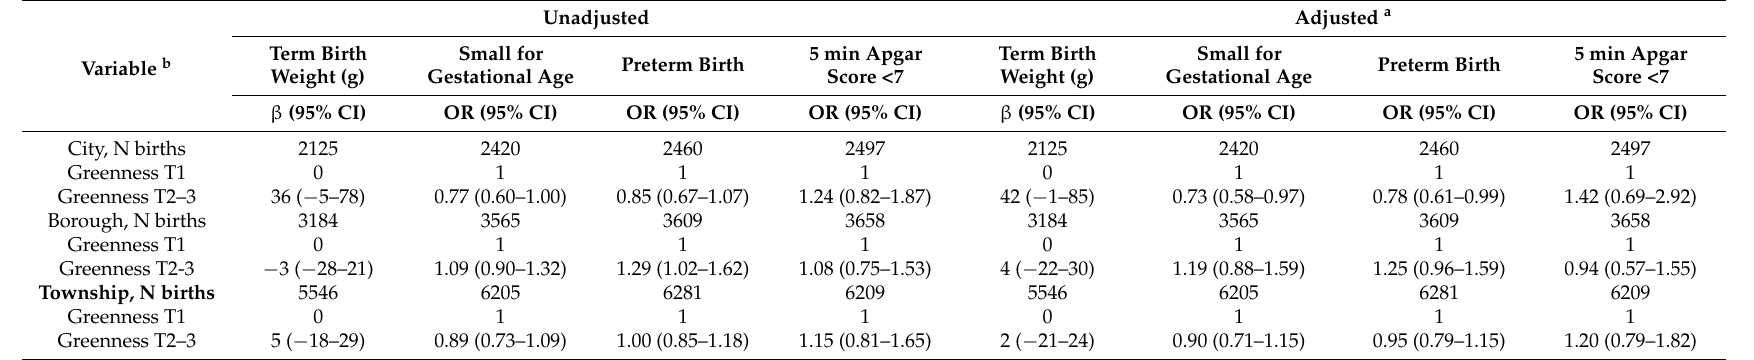
Table 2. Unadjusted and adjusted associations of residential greenness and birth outcomes in restricted